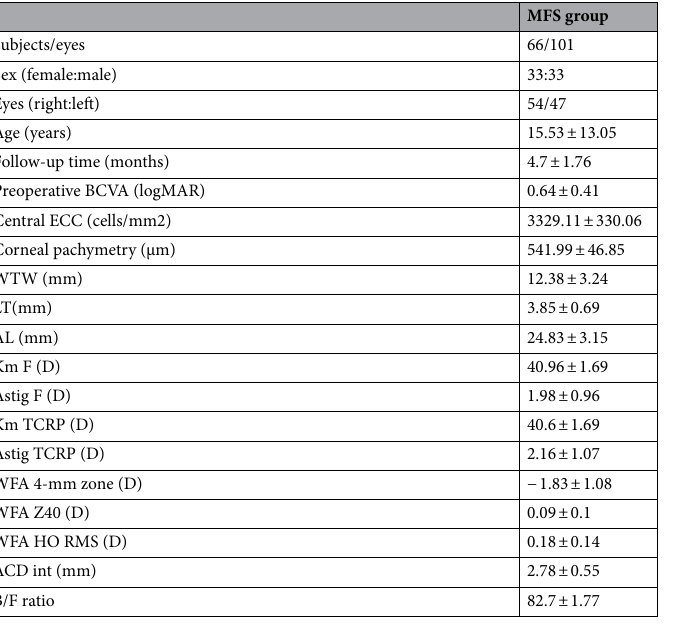
Table 1. Baseline characteristics of the preoperative MFS group. BCVA: best-corrected visual acuity; ECC: endothelial cell count; WTW: white to white; LT: lens thickness; AL: Axial length; Km: mean keratometry; F: front (anterior corneal surface); Astig: astigmatism; TCRP: total corneal refractive power; WFA 4-mm zone: wavefront aberration in the 4-mm zone around the corneal apex; WFA Z40: total corneal spherical aberrations (Z4,0) in the 6-mm zone around the corneal apex; WFA HO RMS: root mean square of the total corneal high order aberrations calculated in the 4-mm zone around the corneal apex; B/F ratio: mean radius of the posterior corneal surface/mean radius of the anterior corneal surface ratio; ACD: anterior chamber depth; Cornea: corneal diameter